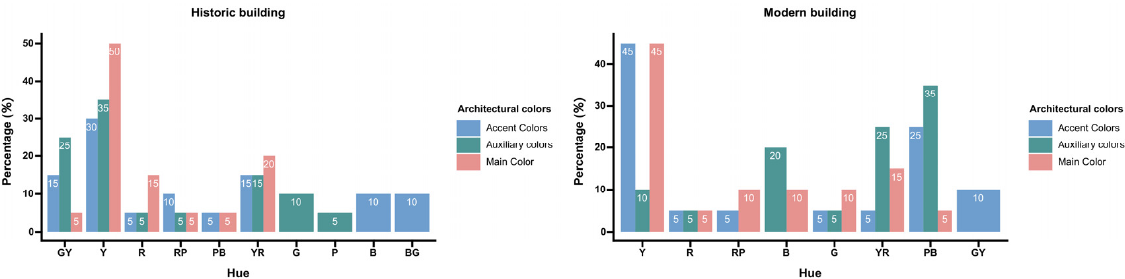
Figure 8. Chromatic composition network of historic and modern buildings.